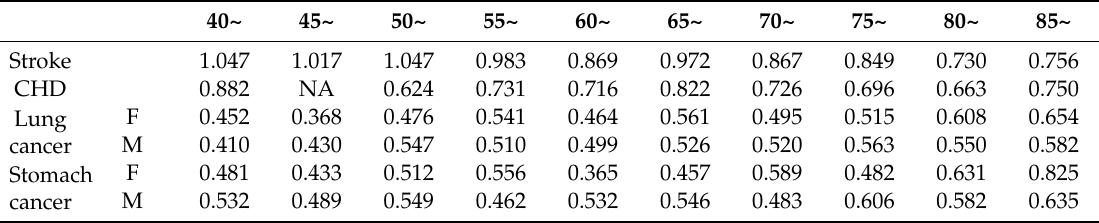
Table 5. The SDs of the center parameter of four